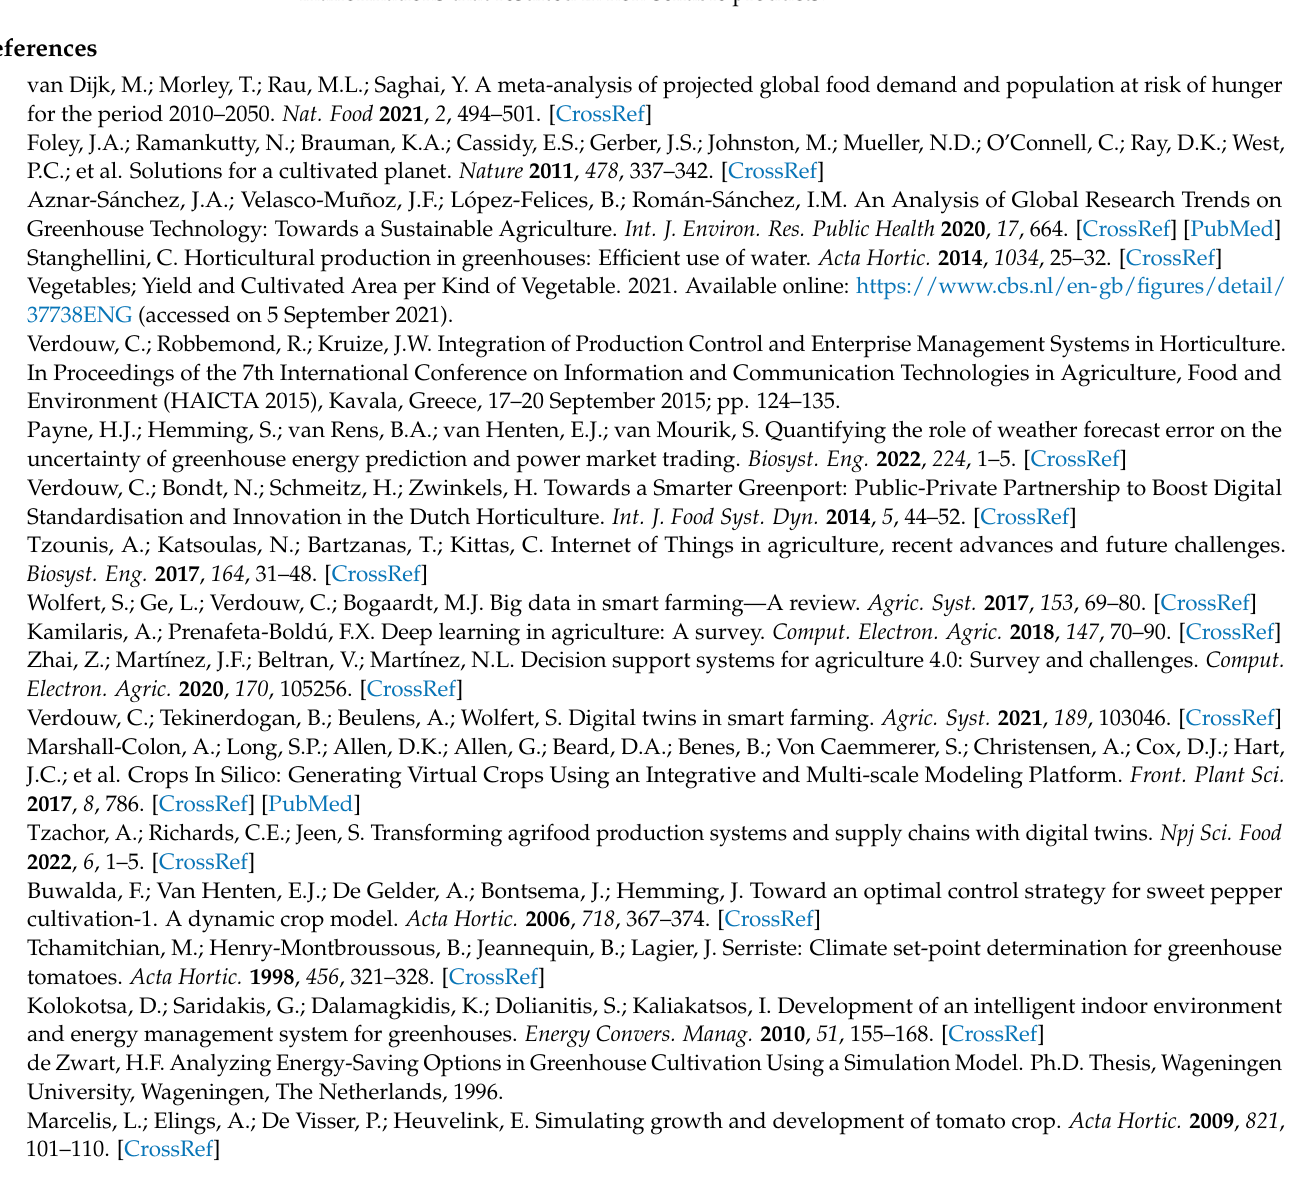
Figure A6. Classification of lettuces at the different harvest moments as Class A, Class B, and Class C lettuces for the first ( left ) and second ( right ) cultivation. The classification was carried out using a standardized protocol that distinguished the harvested products given the satisfaction of the target fresh weight, the presence, and severity of the outer-leaf burn, and the presence of diseases and or malformations that resulted in non-sellable products.